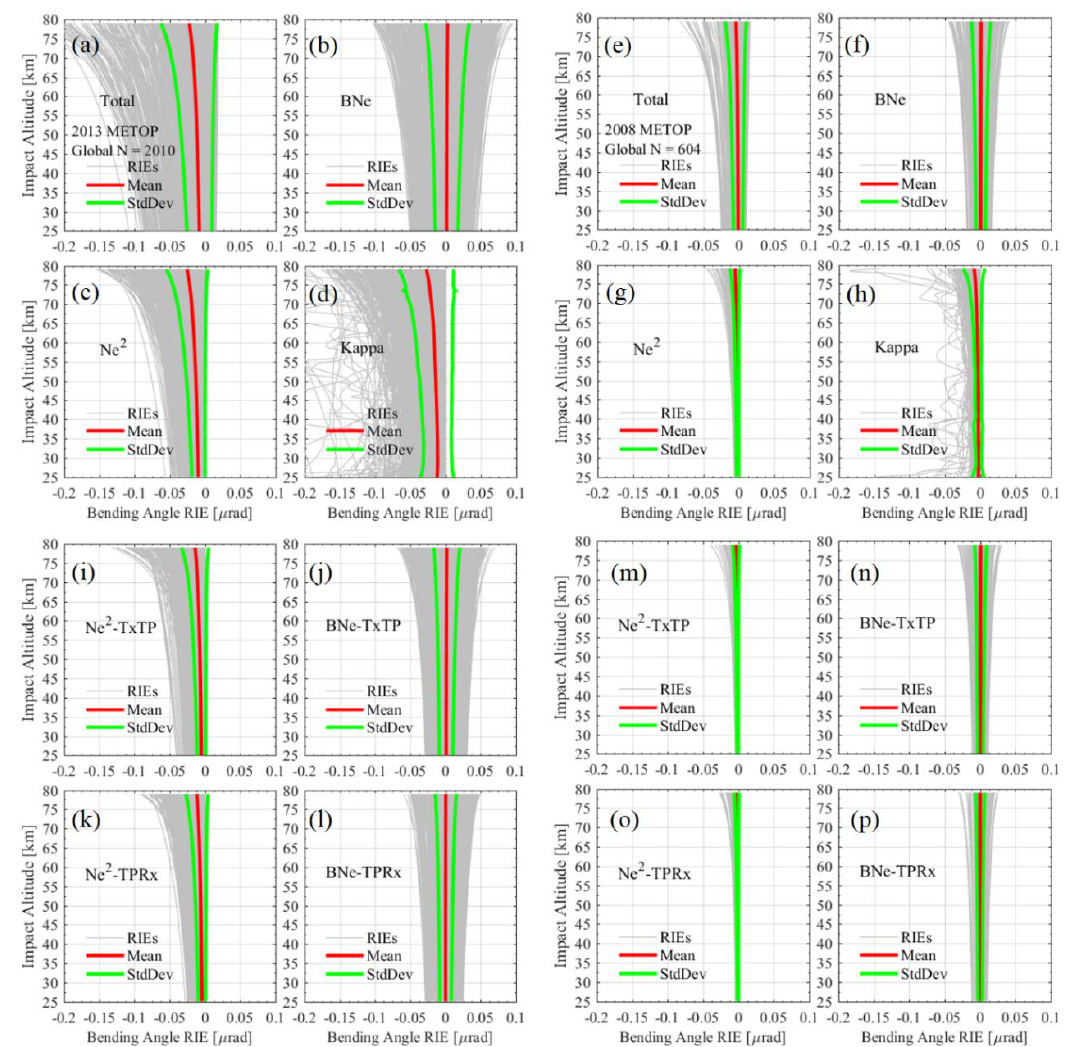
Figure 5. Bi-local and Kappa bending angle RIE correction profiles and their statistics for the global ensemble high solar activity data set (left columns, MetOp-A/-B missions on 15 May and 15 July 2013) and low solar activity data set (right columns, MetOp-A mission on 15 July 2008). In the upper composite panels, the total bi-local bending angle correction (Total) and its BNe and electron-density-squared (Ne 2 ) component terms, and the observed Kappa correction term are shown by subpanels ( a – d ) and ( e – h ). The lower composite panels show the inbound (TxTP) and outbound (TPRx) components of the Ne 2 and BNe terms, in panels ( i – l ) and ( m – p ), respectively. In each subpanel, the individual bending angle RIEs (grey) and their mean (heavy red) and standard deviation (heavy green) are shown.